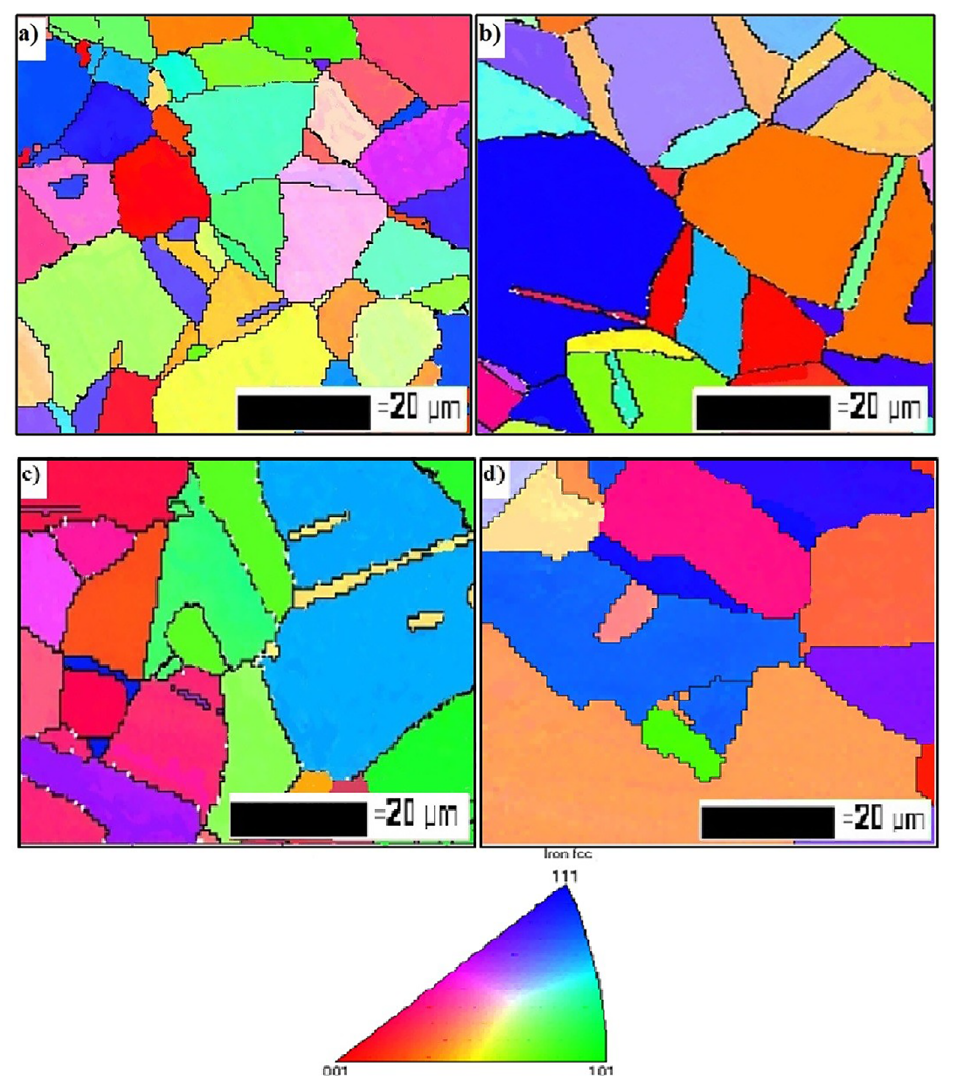
Figure 8. Inverse pole figures of hot rolled samples, with 80% reduction and then solubilized. Increase by 500×. a) 20% manganese, b) 22% manganese, c) 26% manganese and d) 28% manganese. Source: author.